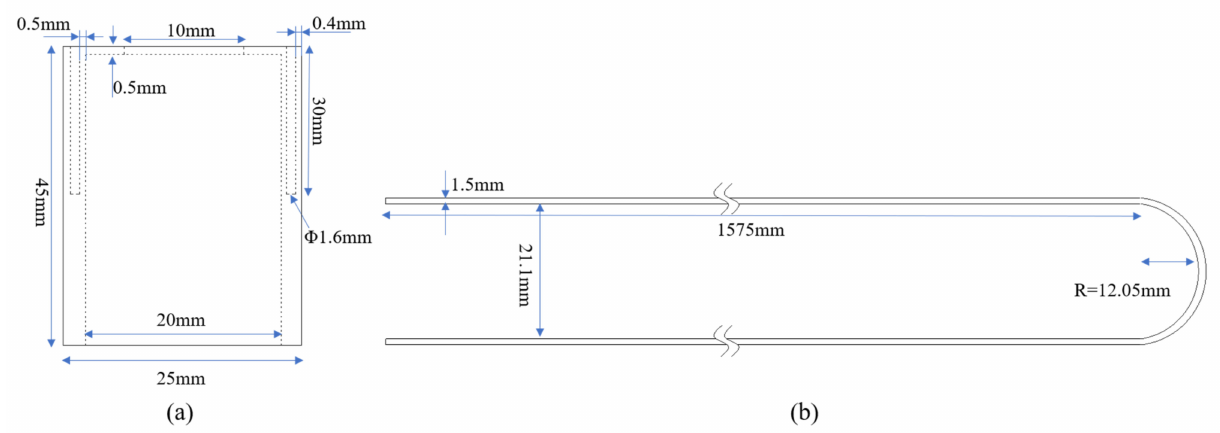
Figure 16. Dimensional drawing of the push–pull anchorage device ( a ) Home view of push–pull tray. ( b ) Home view of U-shaped clip.